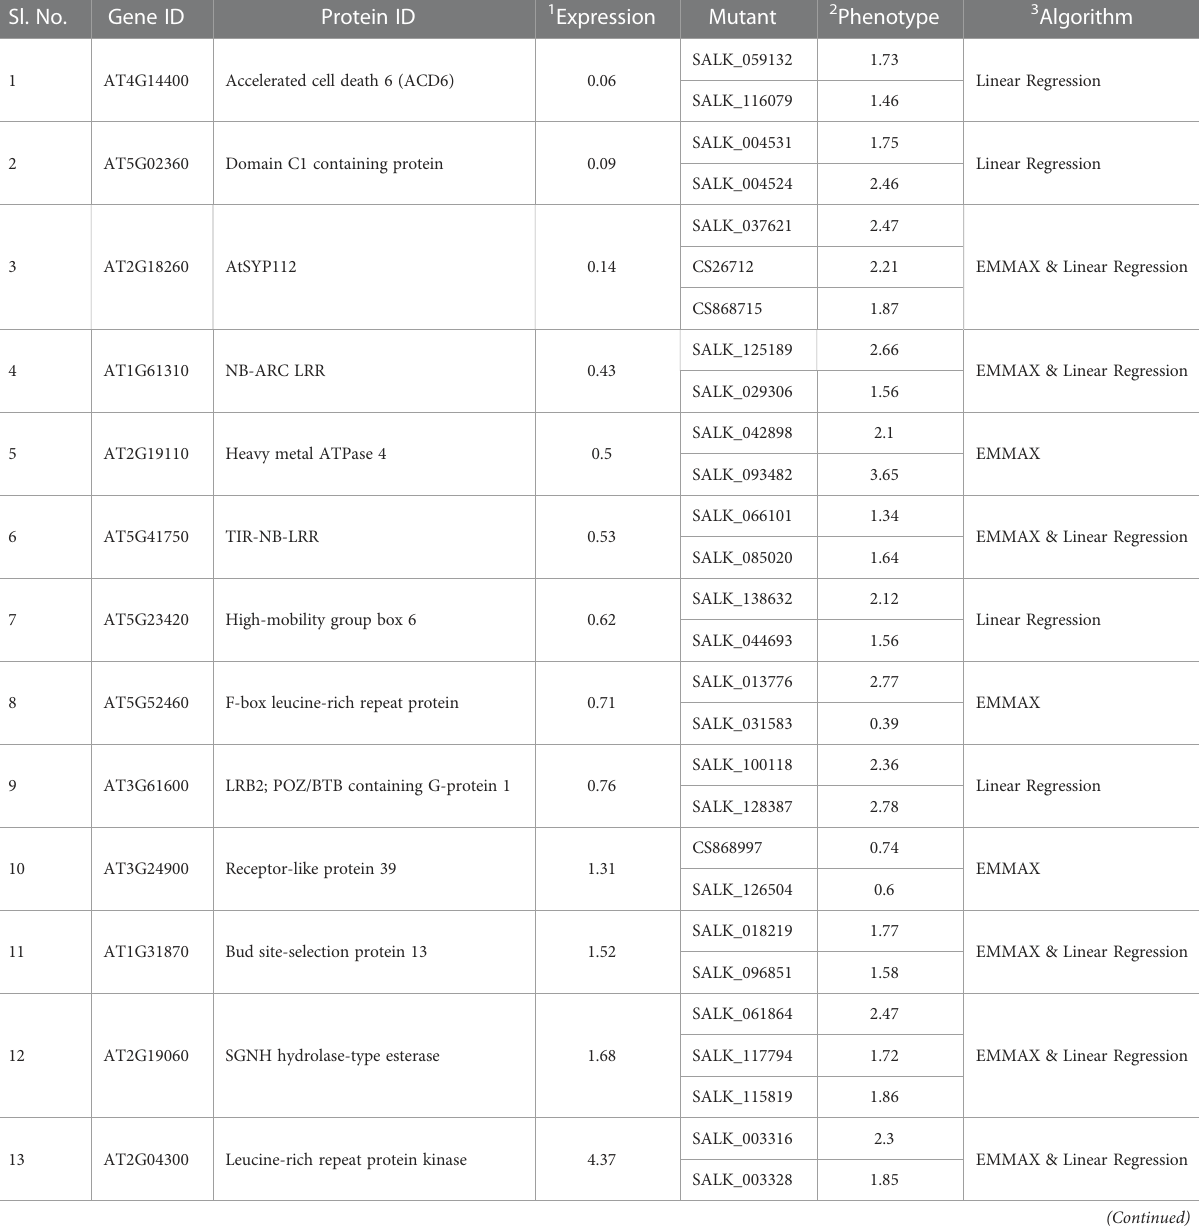
TABLE 1 The 16 identi fi ed Arabidopsis genes involved in the expression of chilling tolerance. Sl.